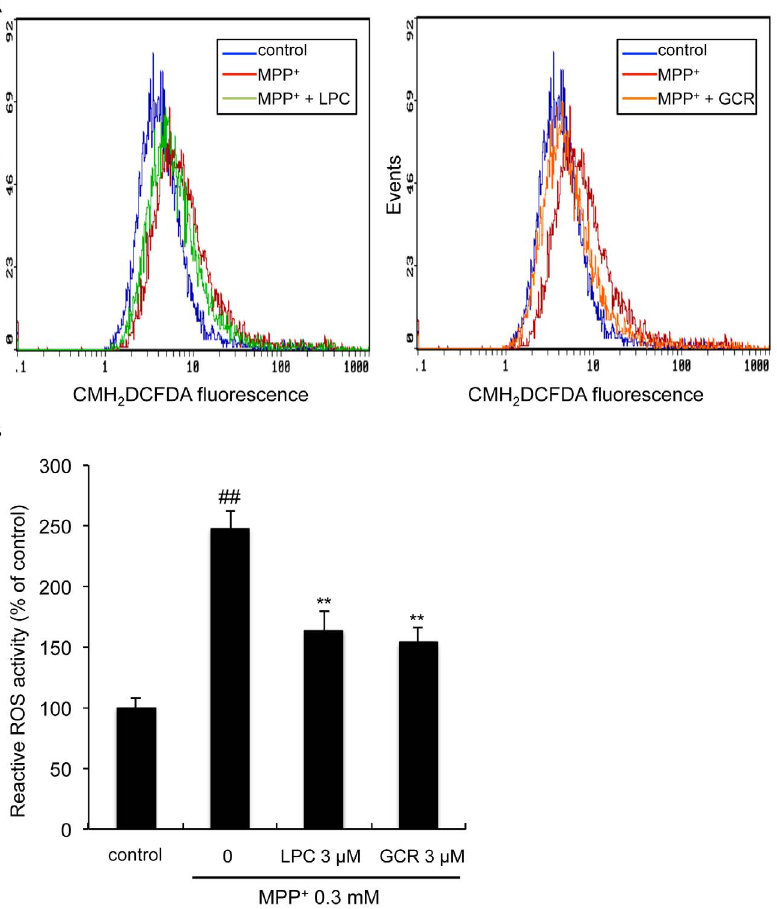
Figure 6. Licopyranocoumarin and glycyrurol decreased MPP + -induced intracellular ROS generation. ( A ) NGF-differentiated PC12D cells were pre-incubated for 1 h with 3 m M licopyranocoumarin (LPC) or 3 m M glycyrurol (GCR), then treated with 0.3 mM MPP + for 12 h. Then, the samples were loaded with 2.5 m M CM-H 2 DCFDA and the fluorescence intensities were measured by flow cytometry. ( B ) The ratio of cells exhibiting ROS production was analyzed. Values are the means of four independent experiments; bars, s.d. ## p , 0.01 compared with control cells. ** p , 0.01 compared with MPP + group cells.